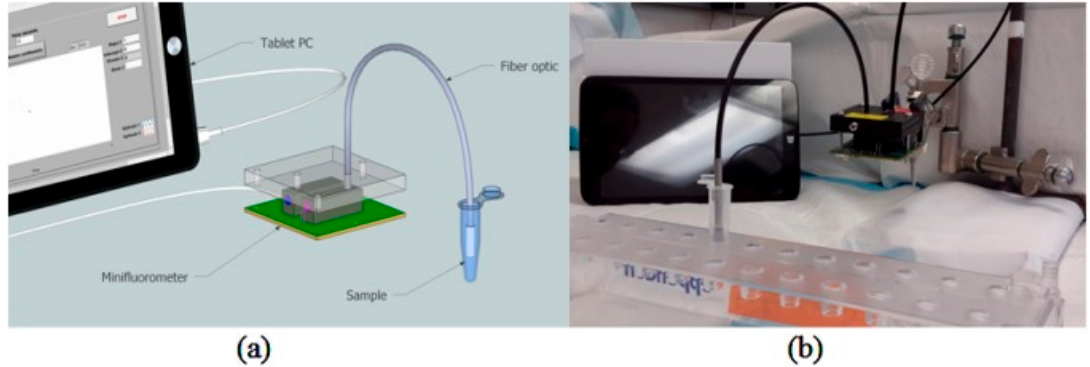
Figure 6. ( a ) A schematic of the fiber optic sensor system. ( b ) In vitro experimental setup. Reprinted with permission from [105].